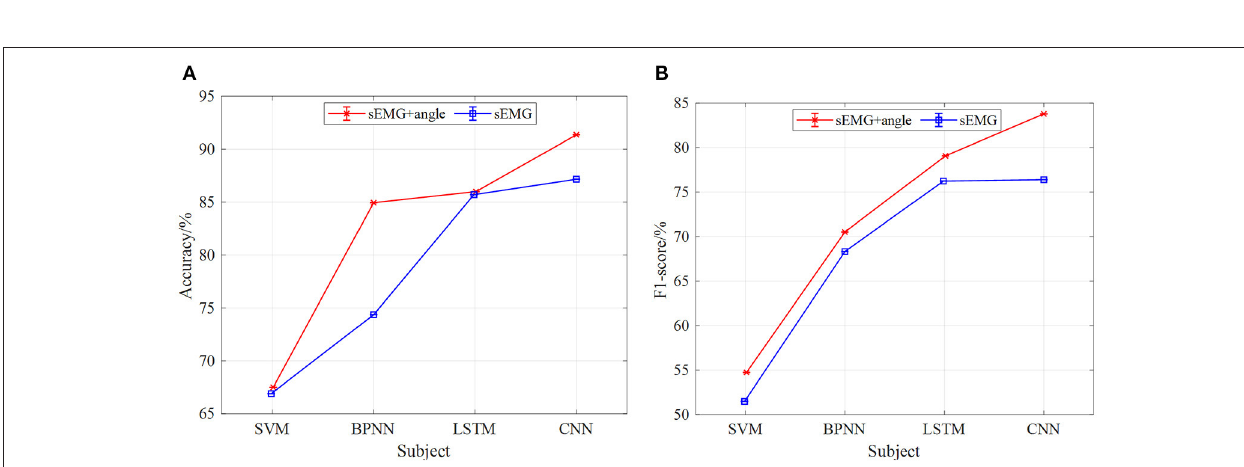
FIGURE 14 | The comparison results of different models of multi-information and single information input with the 5-fold cross-validation method at 2km/h, (A) comparison results of four model accuracy with different input information, (B) comparison results of four models F1-score with different input information.